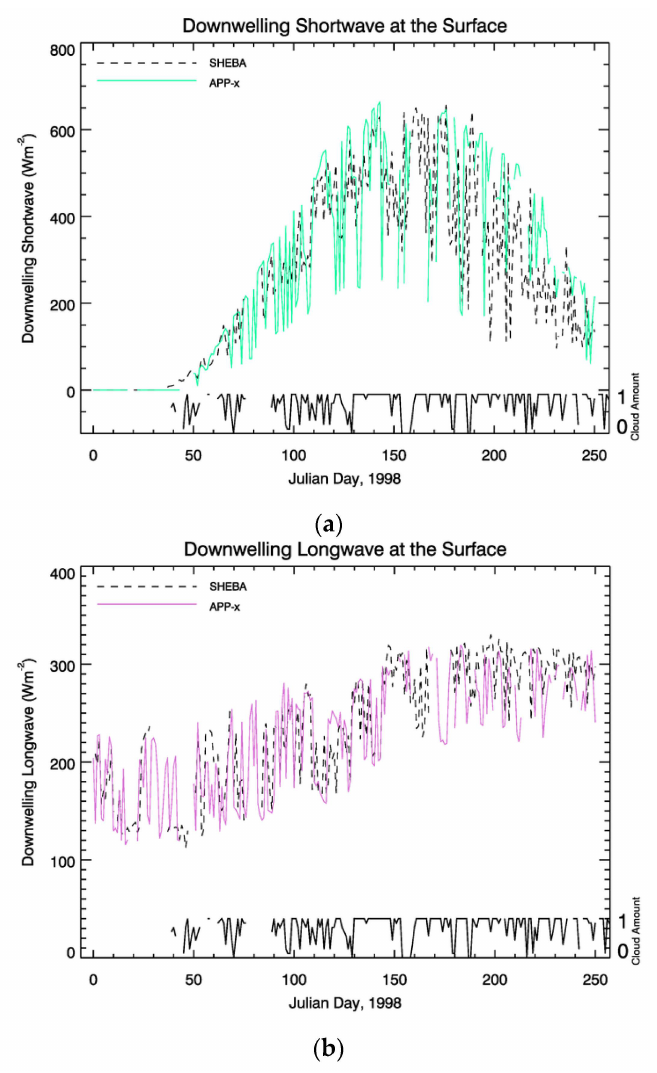
Figure 10. Comparison of satellite-derived and surface measurements of the downwelling shortwave flux at the surface ( a ) and the downwelling longwave flux at the surface ( b ). Cloud amount is also